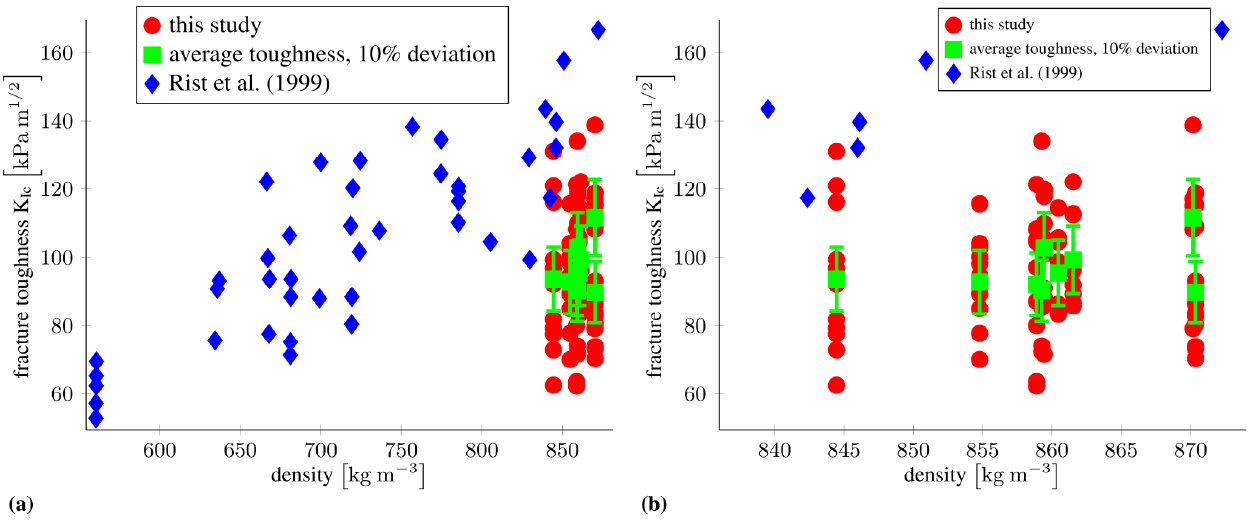
Figure 6. (a) Comparison to results from Rist et al. (1999) and the average of the measured fracture toughness values. (b) Detail magnification of the measured